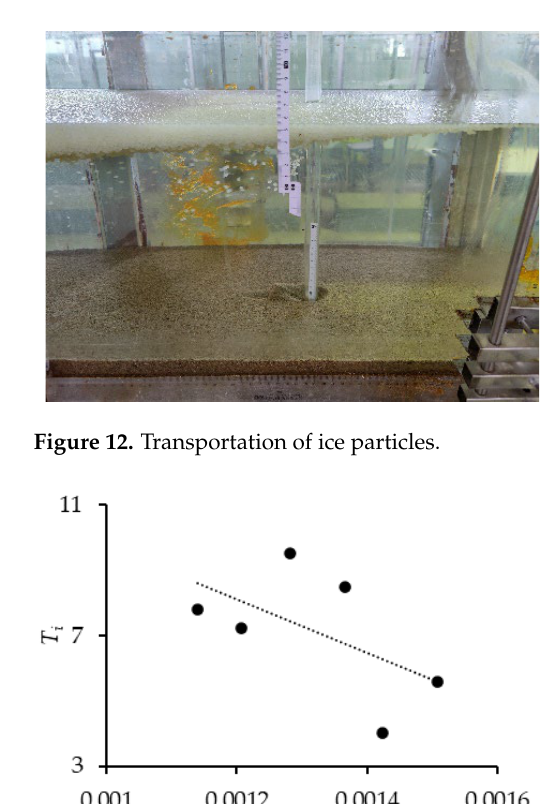
Figure 14. The ratio Ti / h at different cross sections with and without a local scour with the same F r. 3.2. Effect of Ice Jam Evolution on Local Scour The results show that compared to the formation of a scour hole under an open flow condition, the formation of a scour hole under an ice-jammed flow condition can be classified into the following two different categories based on the thickening process of the ice jam: 1.